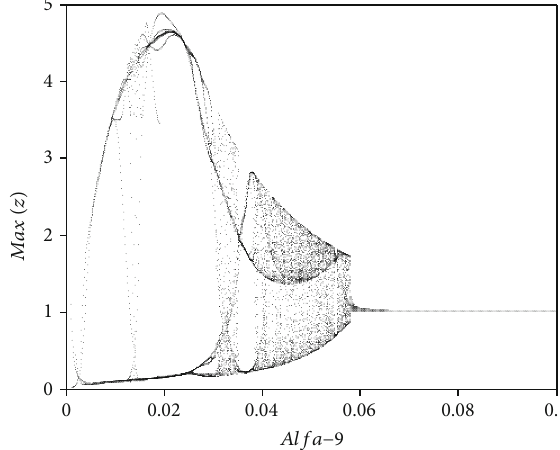
0 : 01 < α < 0 : 1 using the parameter values in 9 in the range 9